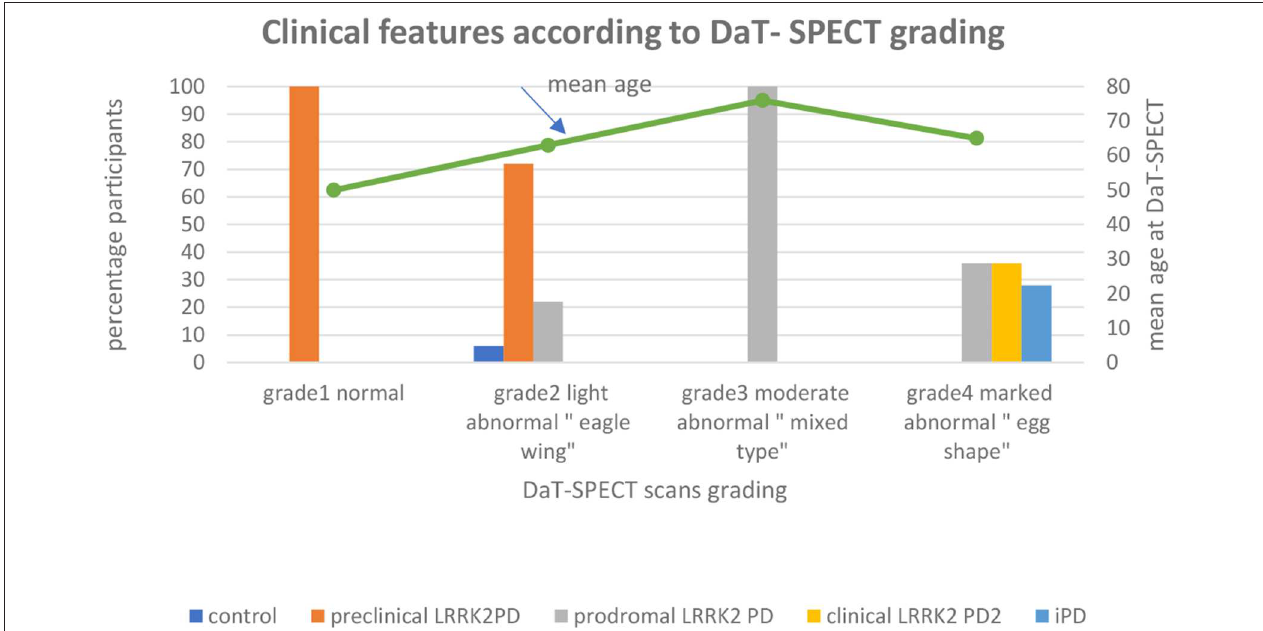
FIGURE 2 | Among the participants with normal DAT-SPECT scans, 100 percent (5/5) have preclinical LRRK2 PD. Among the perticipants with light abnormal “eagle wing” DAT-SPECT scans, 72 percent (13/18) have preclinical LRRK2 PD, 22 percent (4/18) have prodromal LRRK2 PD and the one control patient accounted for 6%. Among the participants with moderate abnormal “mixed type” DAT-SPECT scans, 100% (5/5) have prodromal LRRK2 PD. Among the participants with marked abnormal “egg shape” DAT-SPECT scans, 36 percent (4/11) have prodromal LRRK2 PD, 36 percent (4/11) have clinical LRRK2 PD and 28 percent (3/11) have idiopathic